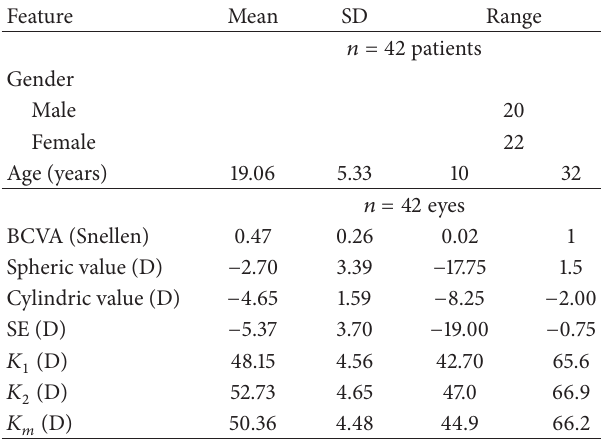
Table 1: Comparison of the demographic features of the patients with KC enrolled in the